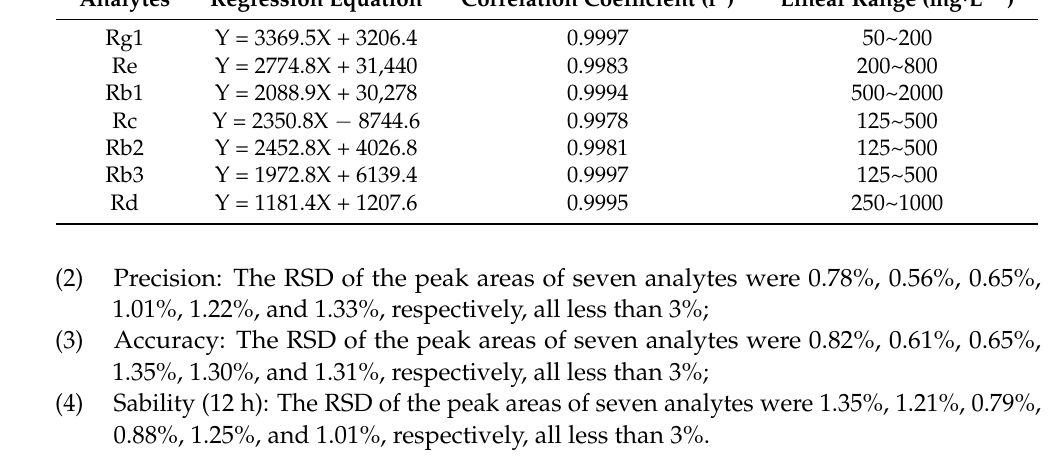
Linearity: The working curves were drawn by plotting the peak areas value versus